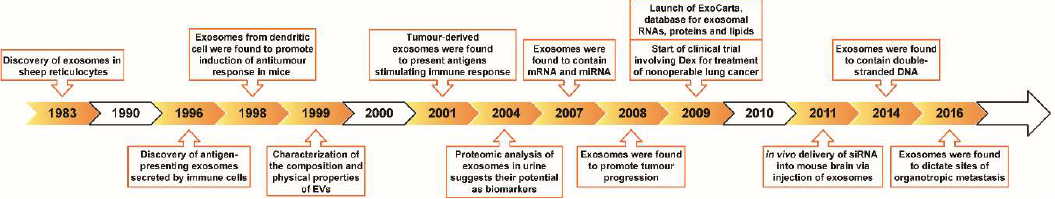
Figure 2. Historic landmarks for the discovery and application of exosomes. Chronological summary of the key events that led to the discovery and application of exosomes and EVs from 1983 to 2016. Exosome biogenesis begins with inward budding of the cellular plasma membrane to form early endosomes. Inward budding of this endosomal membrane then forms late endosomes containing intraluminal vesicles (Figure 3). These endosomes are referred to as multivesicular bodies (MVBs) and contain multiple vesicles carrying various proteins, lipids and nucleic acids of the parent cell. Matured MVBs can either fuse with the plasma membrane (secretory MVBs) or lysosomes (degradative MVBs) [6]. The fusion of MVBs with the cell plasma membrane releases these vesicles into the extracellular milieu as exosomes [7] (Figure 3). MVBs can also fuse with lysosomes and subsequently be degraded [8]. Other unconventional pathways of biogenesis include the release of exosomes from secretory MVBs generated by bypassing the Golgi apparatus [9,10]. However, MVBs are not the only mechanism by which cells release exosomes into the extracellular space. Exosomes can also be secreted via budding instead of MVBs. For example, Jurkat T-cells have been shown to secrete outward budding vesicles enriched in exosomal protein CD63 [11].